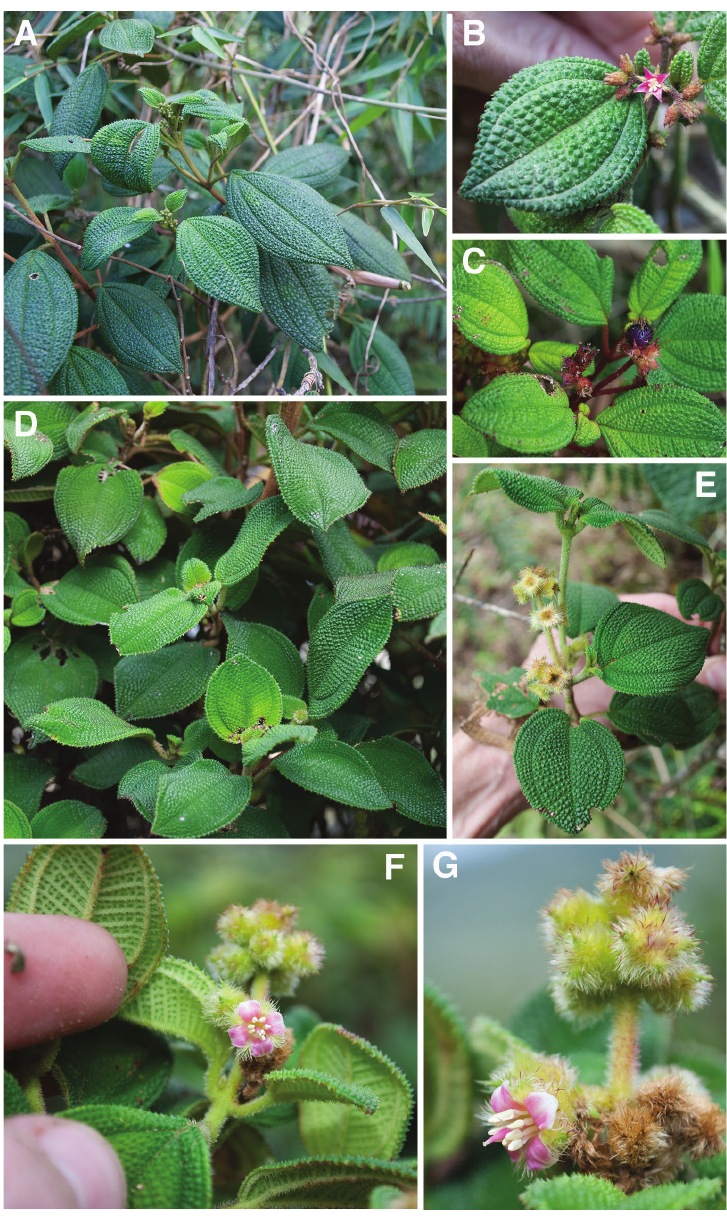
Figure 19. Photos of Miconia lima ( A–C ) and Miconia limoides. ( D–G ). A habit and adaxial leaf surface of M. lima , also with immature inflorescences ( Majure 5983 ) B flowering branch of M. lima showing dark pink petals ( Majure 6020 ) C fruiting branch of M. lima with dark purple fruit ( Majure 6036 ) D vegeta- tive material of Miconia limoides showing habit ( Majure 5959 ) E fruting branch of M. limoides also show- ing reflexed stem hairs ( Majure 5958 ) F flower of M. limoides (frontal view) showing pink petals and radi- ally disposed stamens G typical compact inflorescence and side view of flower of M. limoides showing pink style and expanded middle portion of style ( F–G from Majure 5959 ). All photos taken by L.C.